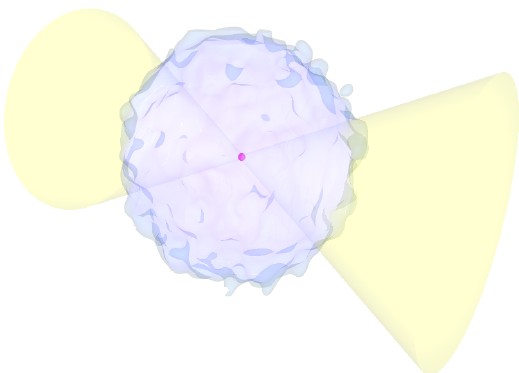
Figure 1. Pictorial representation (not to scale) of the system under study: a single atom (red sphere) is trapped in an optical tweezer (yellow beam) and is immersed in a bath of atoms of a different species (blue